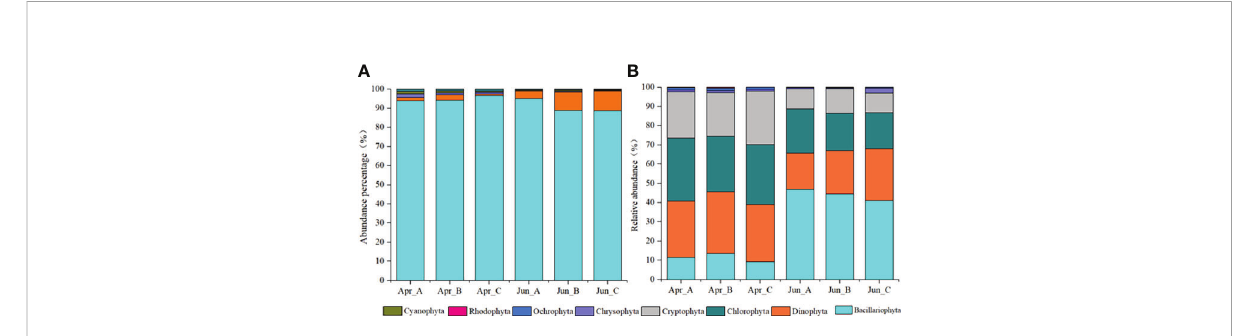
FIGURE 2 Temporal variation in the relative abundances of phytoplankton phyla based on morphological observations (A) and high-throughput sequencing (B) approaches.